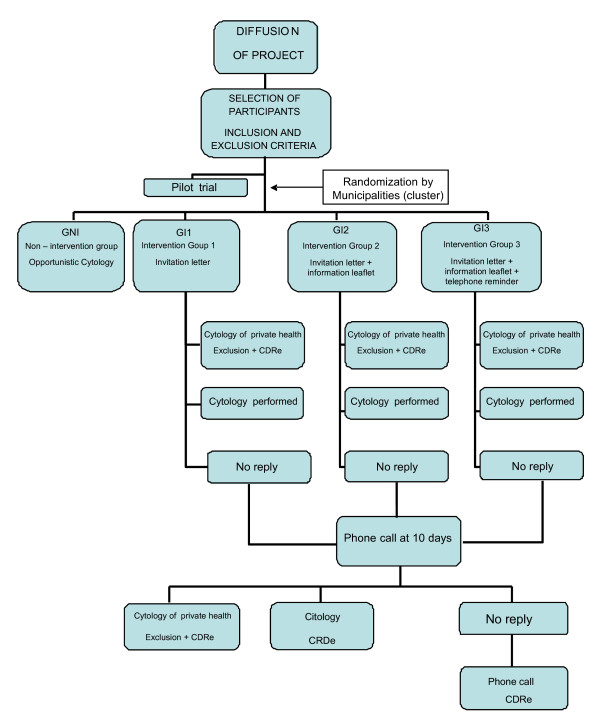
Study Algorithm.